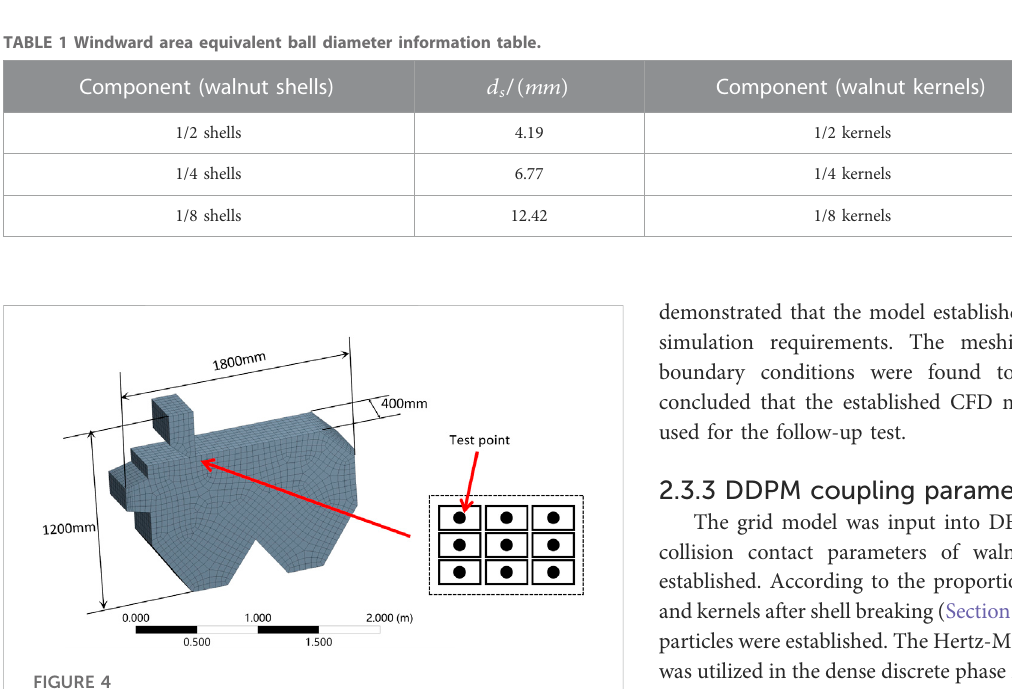
FIGURE 4 Winnowing device room size labeling and grid diagram.